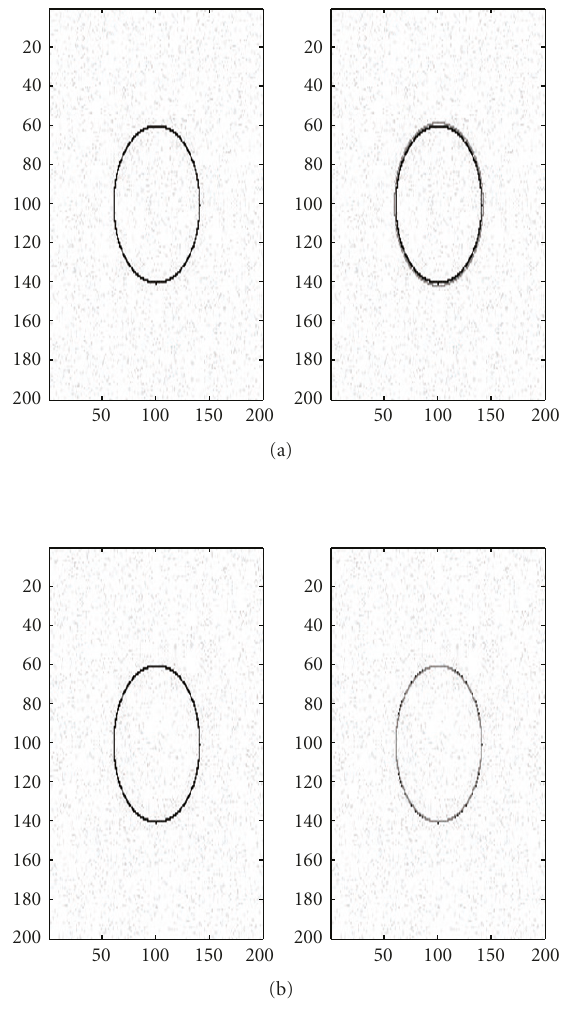
Figure 4: One circle: radius estimation by the proposed method and GHT: (a) processed image and result with our method, (b) pro- cessed image and result with